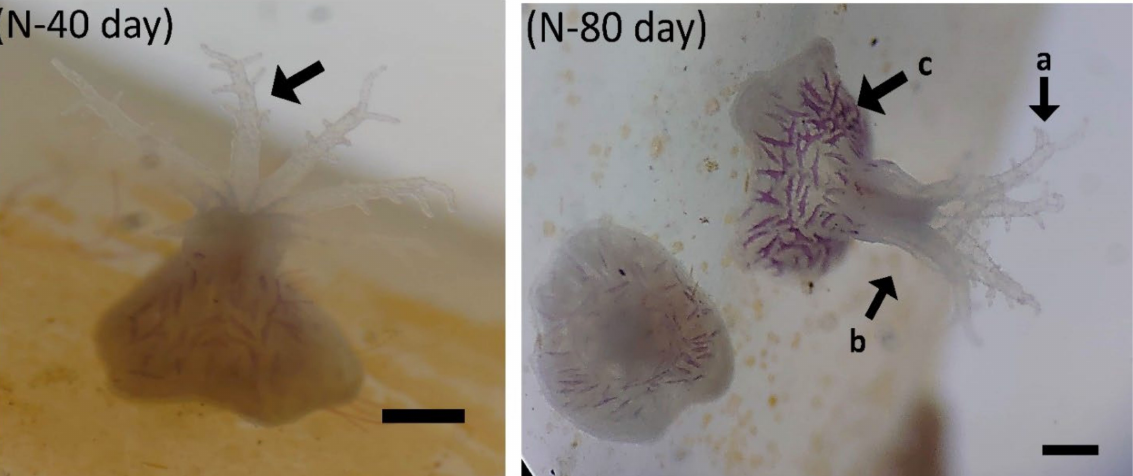
Figure 9. The effect of feeding on Briareum violacea juvenile development during temperature and salinity stress. N, nonfeeding group (scale bar: 100 µ m). Forty days: in the N group, the polyp is about 200 µ m long and spicules have not been observed (indicated by the arrow a, tentacles of polyp). Eighty days: in the N group, no zooxanthellae were found in polyps or coenosarc tissues (indicated by the arrows; a, tentacles; b, polyp; c, coenosarc tissue). The polyp has no schizogamy at